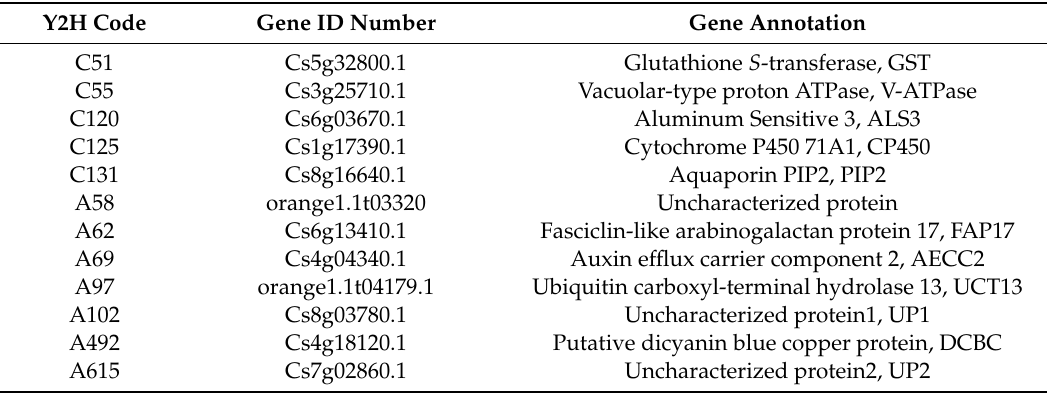
Figure 5. Candidate proteins interacted with ALS3 ( A ) and CAD ( B ) in yeast mating. Double-dropouts minimal media (DDO): single-dropouts (SD) / -Trp / -Leu; DDO / X / A: SD / -Trp / -Leu / X-a-Gal / Aureobasidin A (AbA); quadruple-dropout / X / A (QDO / X / A): SD / -Trp / -Leu / -His / -Ade / Xa-Gal / AbA. Table 1. Analysis of the inserted sequences from screening of cDNA